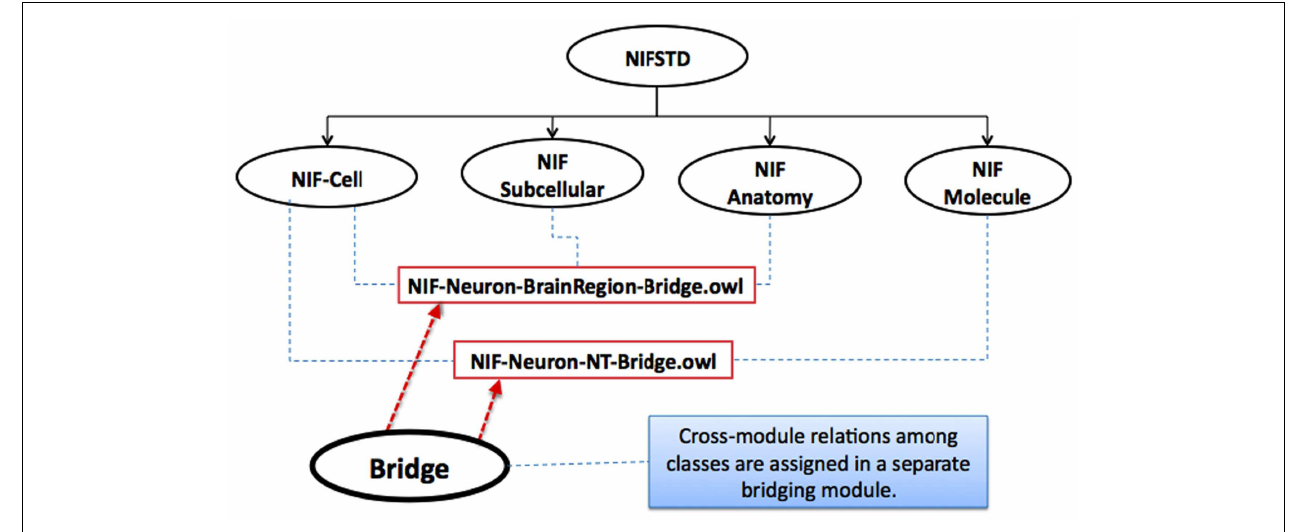
FIGURE 1 |Two example bridging OWL modules in NIFSTD (rectangular boxes) that contain class property associations between multiple core